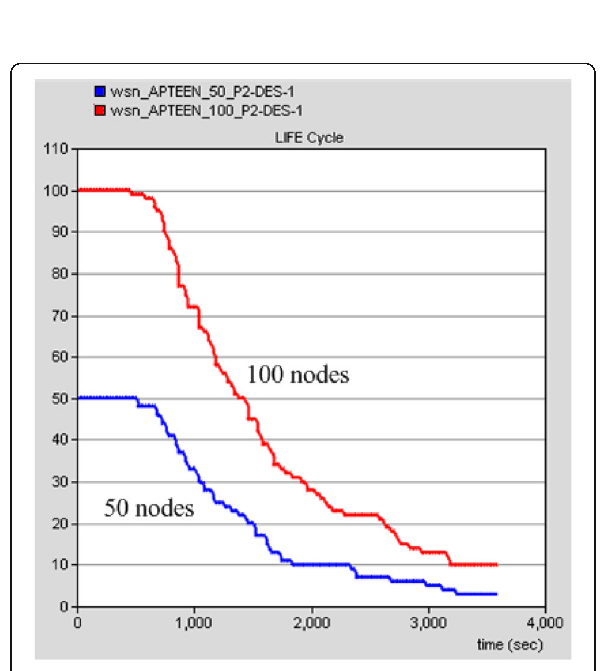
Fig. 9 The life cycle of APTEEN compared in different scales. This figure shows the network life cycle of APTEEN compared 100 nodes with 50-node network topology. The network life cycles of both topologies show a downward trend stably. And the death time of the first node is also very close, so this paper established APTEEN network topology effectively